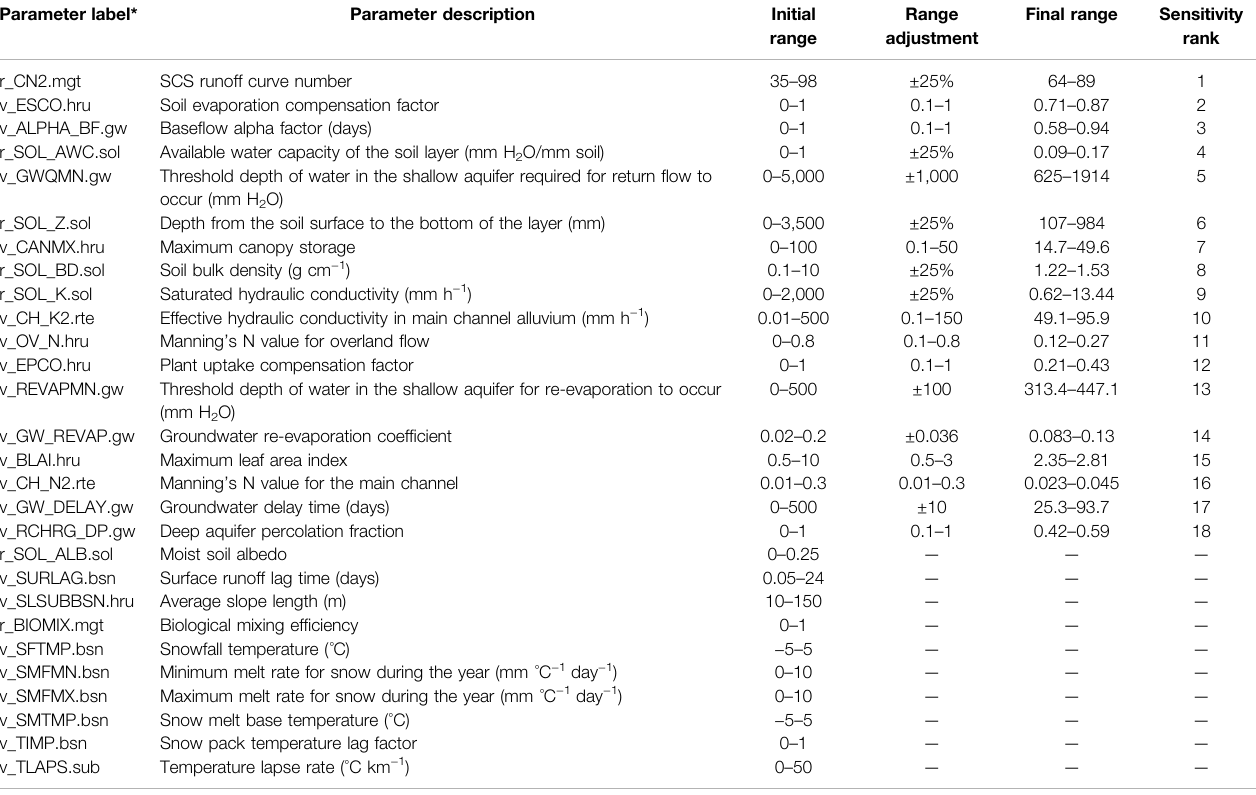
TABLE 2 | Results of the sensitivity analysis and SWAT calibration procedure (the initial range, range adjustment in calibration, and fi nal range) for the blue and green water parameters in the Xiangjiang River Basin. Parameter